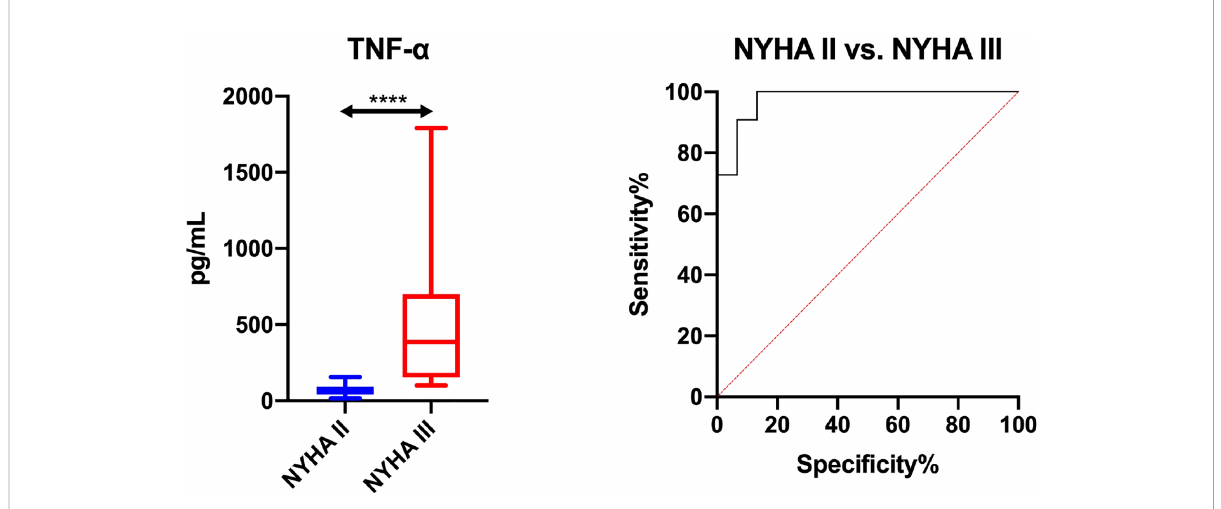
FIGURE 4 Diagnostic signi fi cance of salivary TNF- a for evaluating severity of heart failure symptoms according to the New York Heart Association classi fi cation (NYHA II vs. NYHA III). The results are presented in box-and-whisker plots as median (minimum-maximum). Kruskal-Wallis ANOVA analysis of variance along with Dunn ’ s post hoc test was applied for comparisons between the multiple groups. Analysis of the diagnostic utility of biomarkers was measured using the receiver operating characteristic (ROC) analysis. ****p<